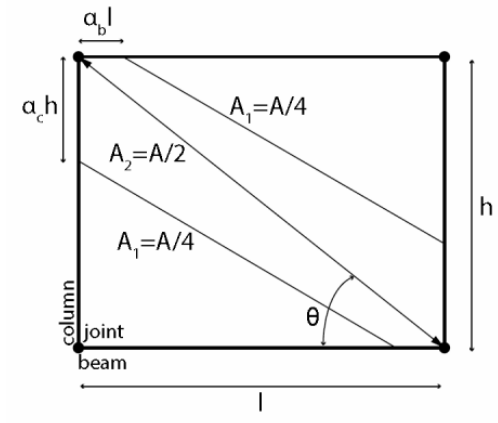
Figure 8. Three-strut model (adapted from Ref. [9]). For the area of the diagonal struts, El-Dakhakhni et al. (2003) [9], suggested A 1 = A /4 for the off-diagonal struts and A 2 = A /2 for the diagonal one, where the total area A was computed by ( 1/ α ) α c c ht A = cos θ where t the thickness of the infill, and θ = tan| − 1( h / l )| the diagonal angle. A stress-strain model was proposed for the masonry infill panel, as shown in Figure 9, computed by ε 1 = ε p − 0.001, ε 2 = ε p + 0.001 and ε = 0.01.